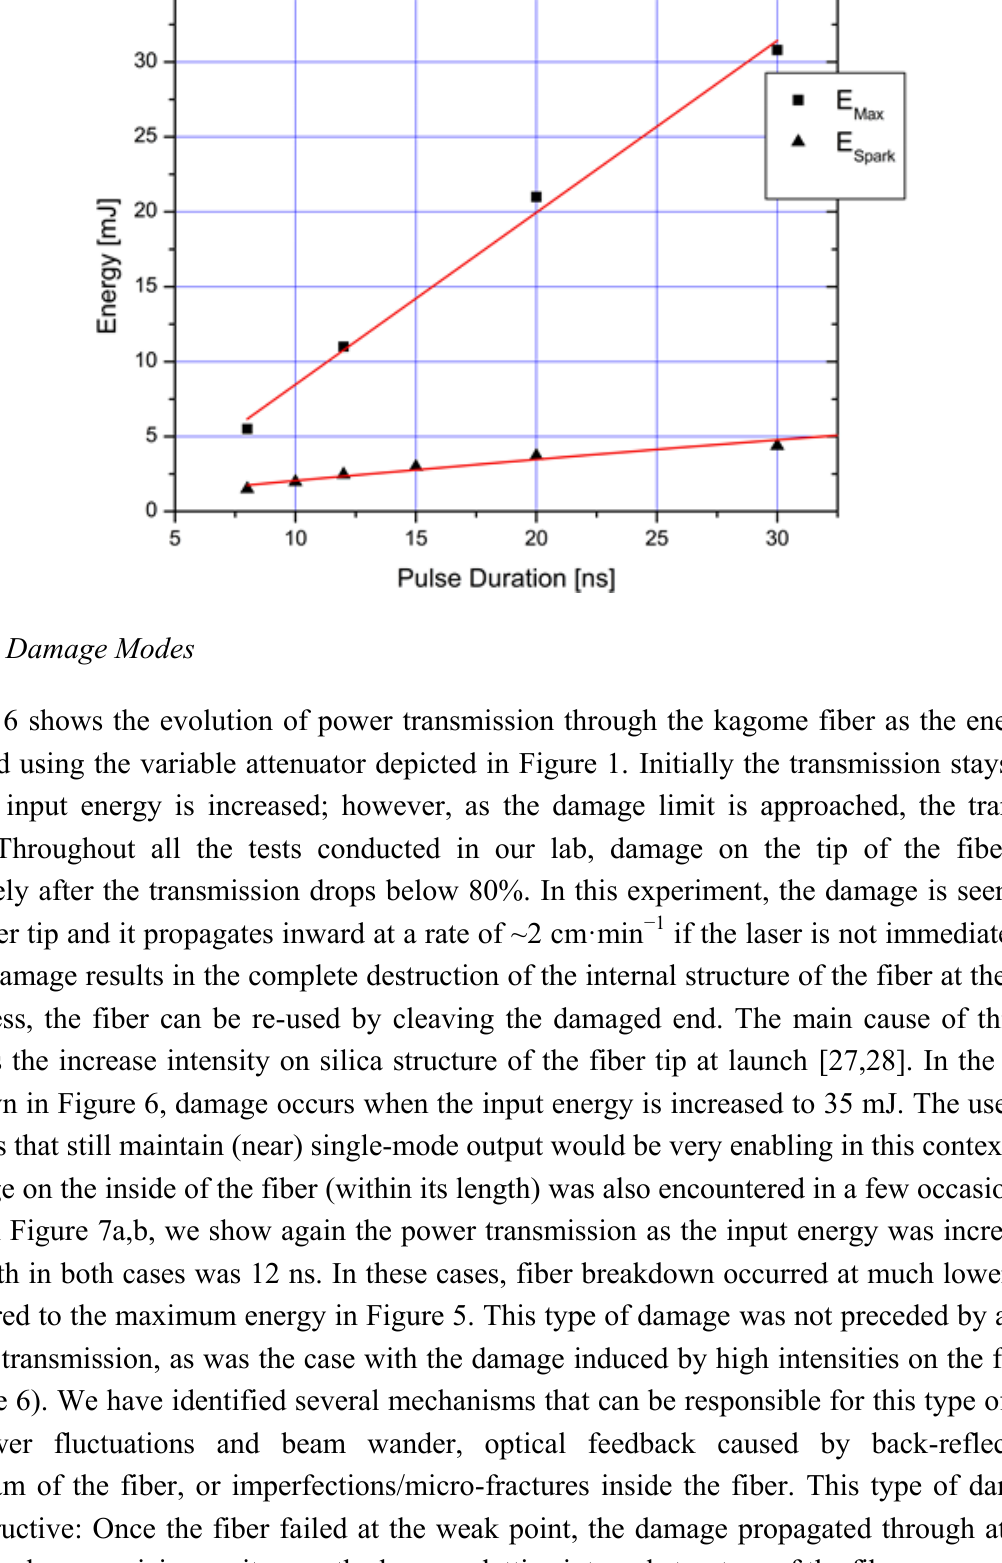
Figure 5. Dependence of maximum laser energy before damage ( E energy to spark at output (E